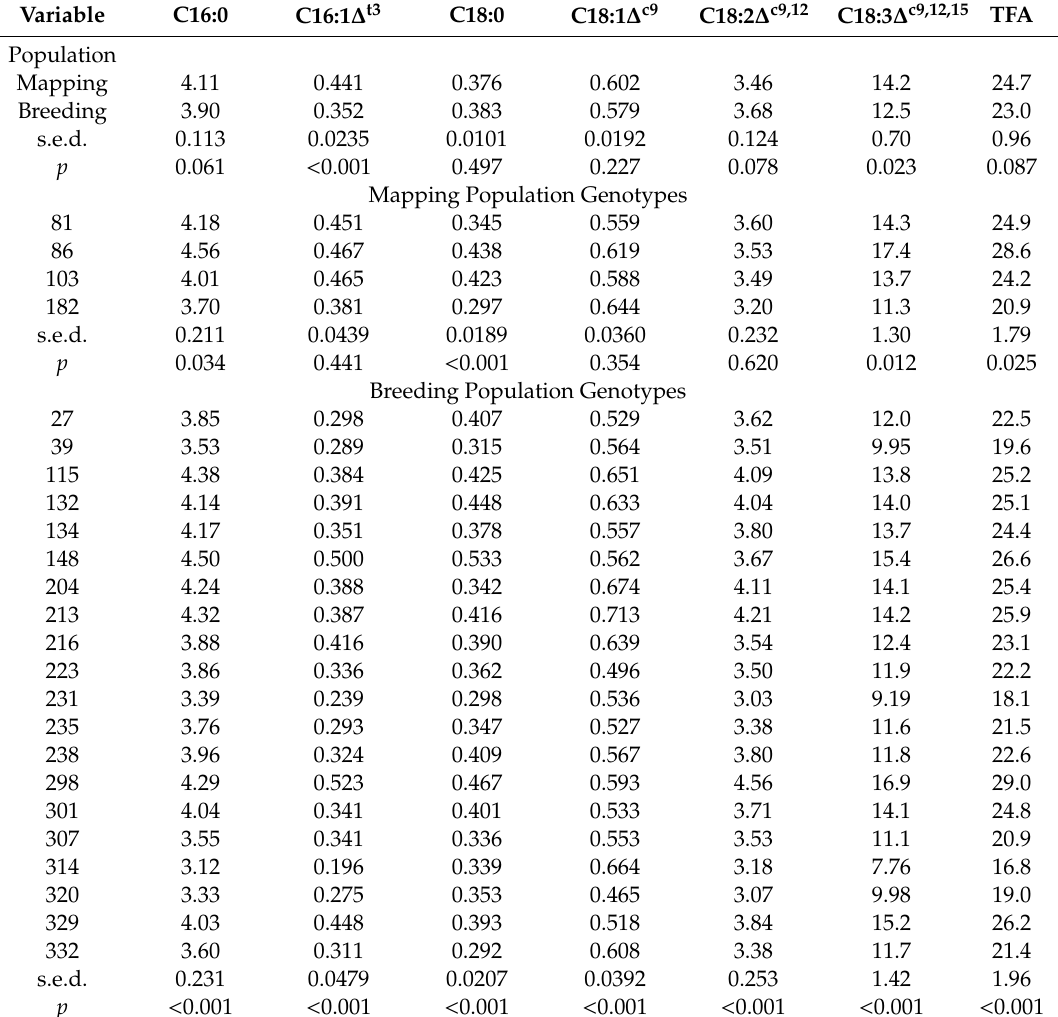
Table 2. Individual and total fatty acid concentration (g kg − 1 DM) of perennial ryegrass genotypes from two distinct